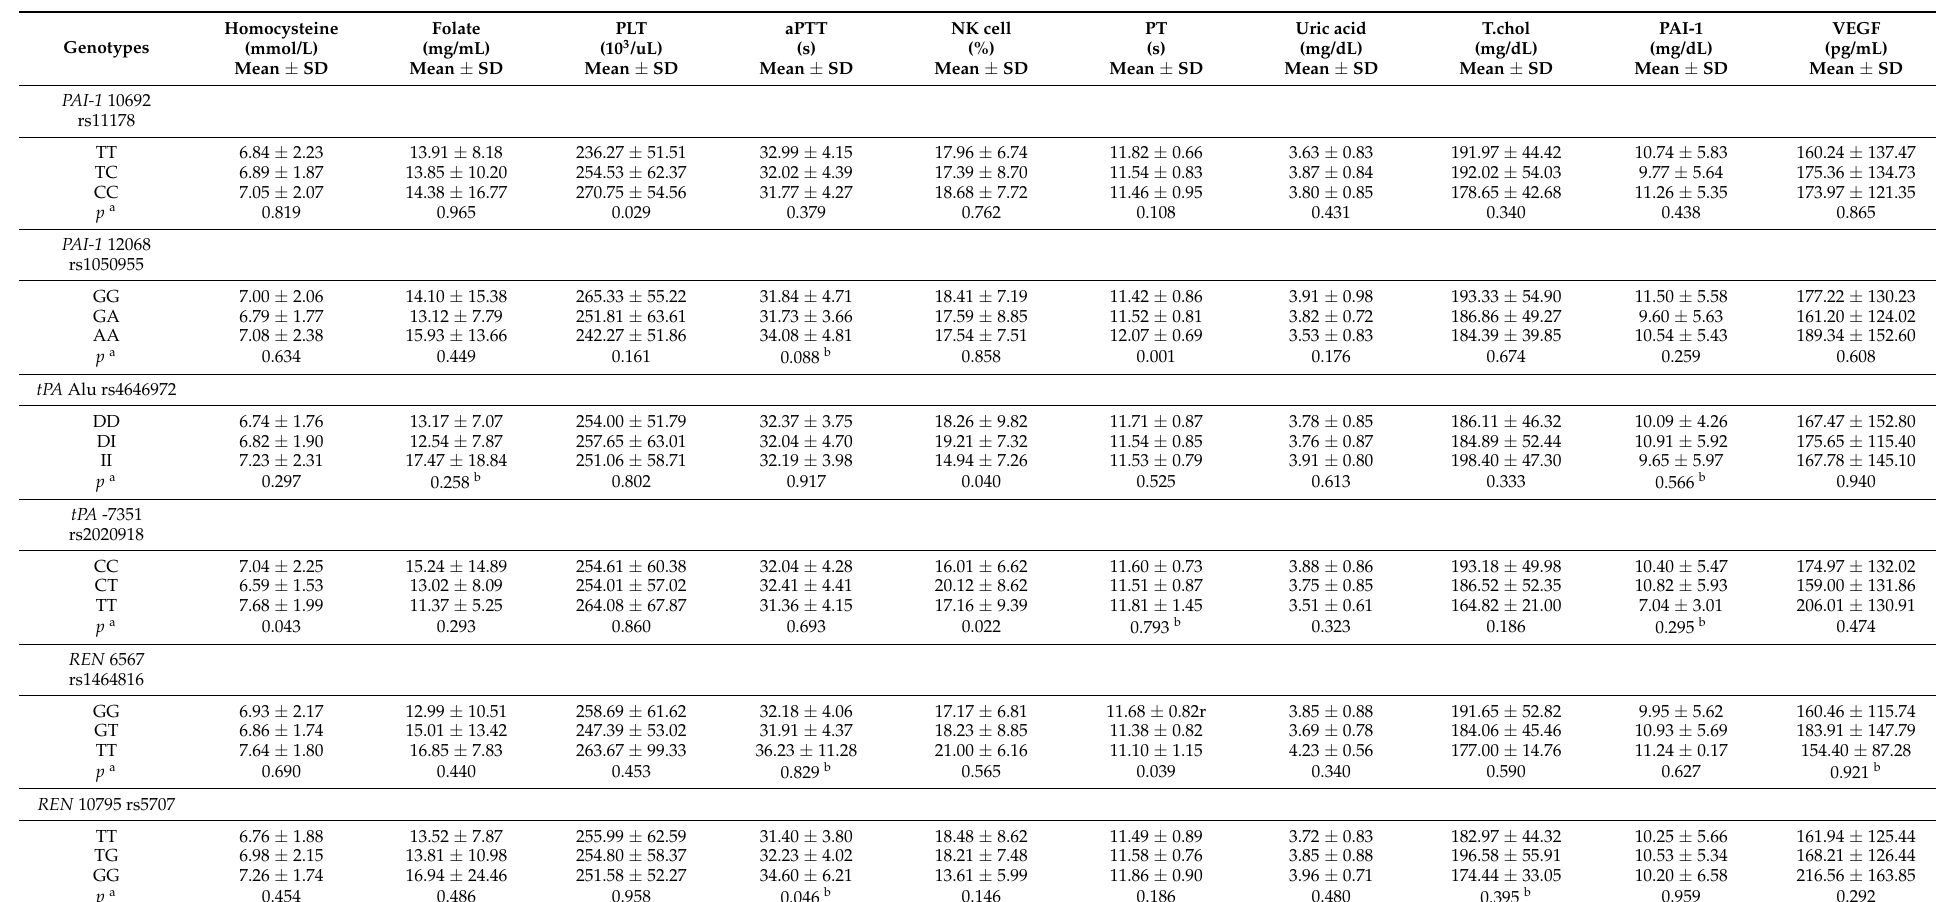
Table 4. Differences of various clinical parameters according to PAI-1 , t-PA and REN gene polymorphisms in RPL